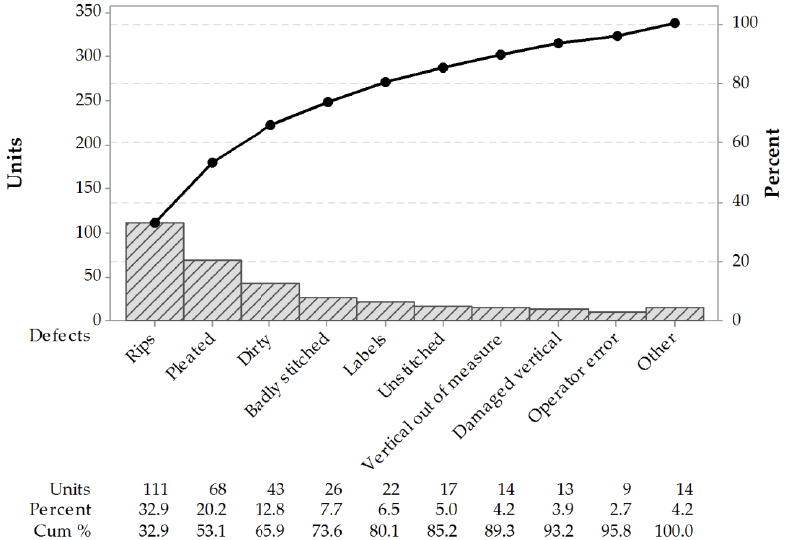
Figure 6. Pareto diagram of the Reex project.